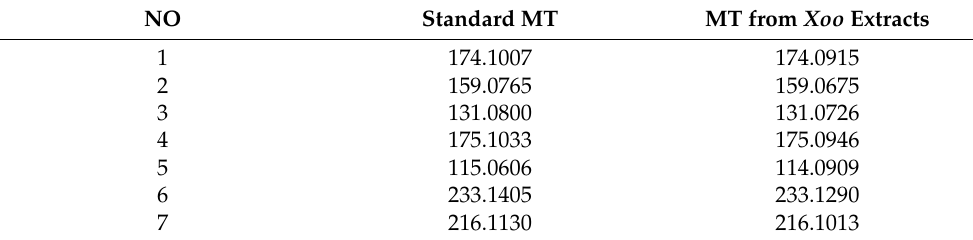
Figure 1. Detection of MT. ( A ) Mass spectrometry analysis of standard MT. ( B ) Mass spectrometry analysis of MT from Xoo extracts. Xoo cells were harvested after 24 h and the metabolites were extracted by ethyl acetate. The samples were reconstituted in 200 µ L methanol and analyzed by mass spectrometry. Table 2. Top 7 peaks of MS/MS fragments from standard MT and MT from Xoo